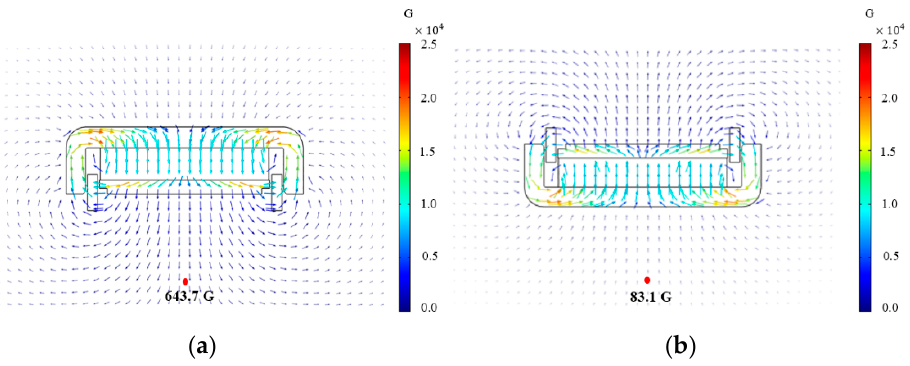
Figure 10. Magnetic flux line: ( a ) prototype; ( b ) second design.